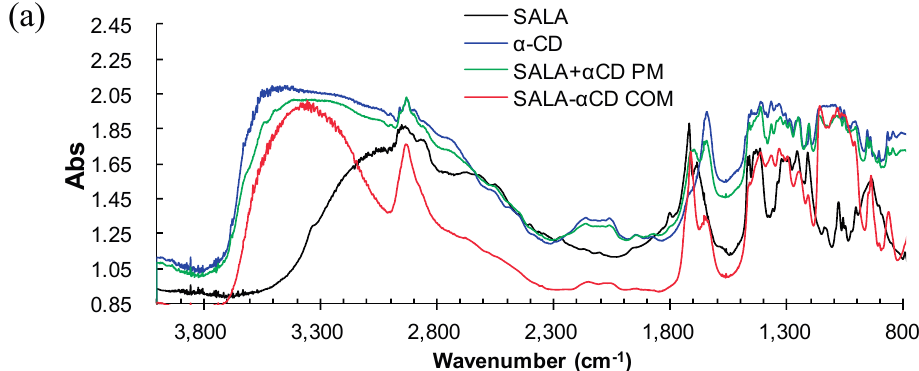
Figure 5. Micro-FT-IR spectra of SALA, SALA + CD physical mixture (PM) and SALA-CD complex (COM). (( a ) α -CD; ( b ) β -CD and ( c ) γ